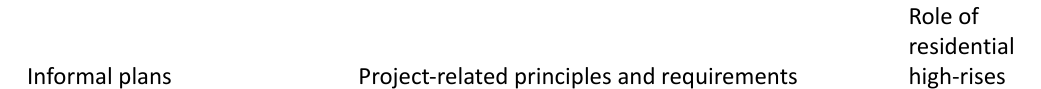
Table 1. Approaches to informal planning for high‐rises in five German